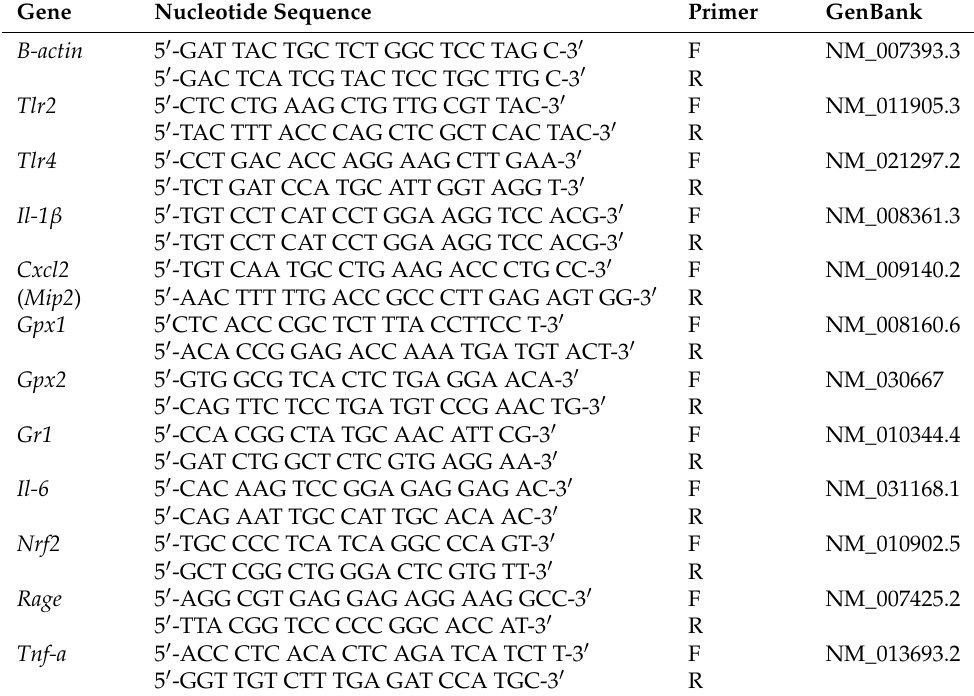
Table 1. Nucleotide sequence of the specific primers used for PCR amplification (Mouse). Gene Nucleotide Sequence Primer GenBank